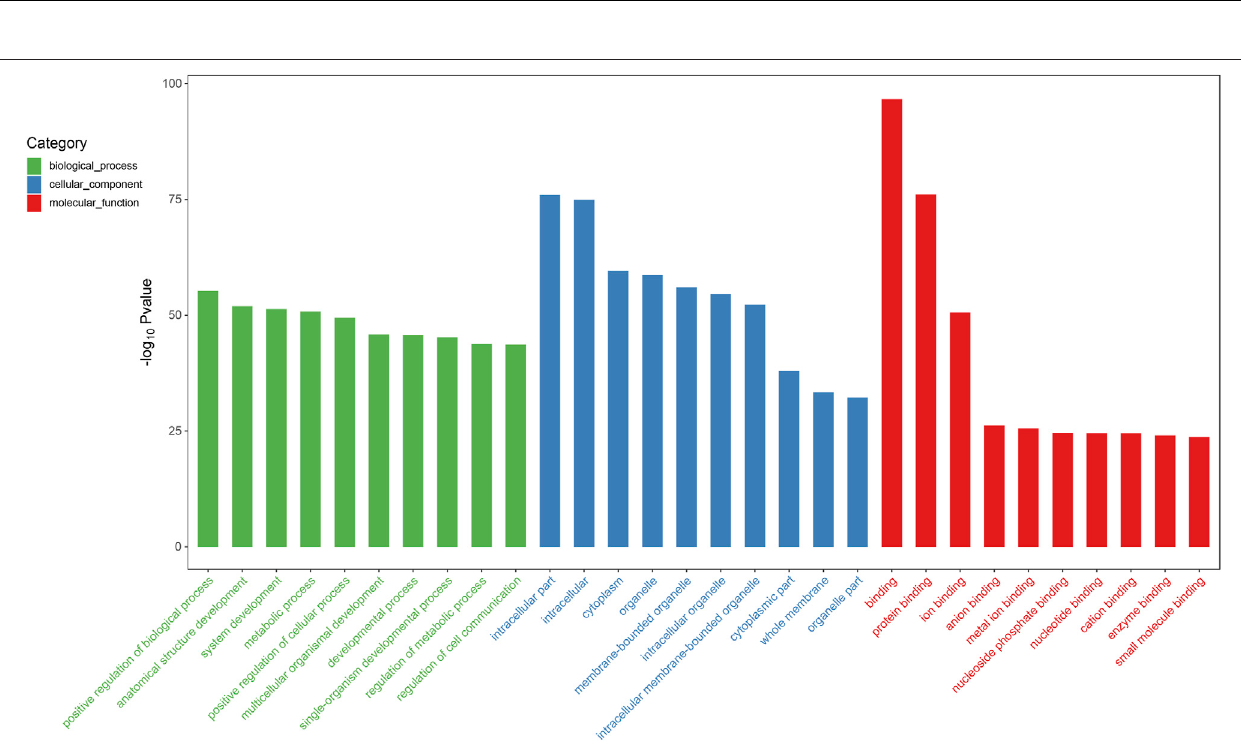
FIGURE 5 | Top 10 signi fi cant enriched GO terms analysis of miRNAs. Differentially expressed miRNAs were mainly involved in biological process, cellular component,andmolecularfunction.Comparedwiththenormalsubjects,thesigni fi cantlyover-presentedmiRNAsintheCRSwNPgroupweremainlyinvolvedinpositive regulation of biological process, intracellular part, and